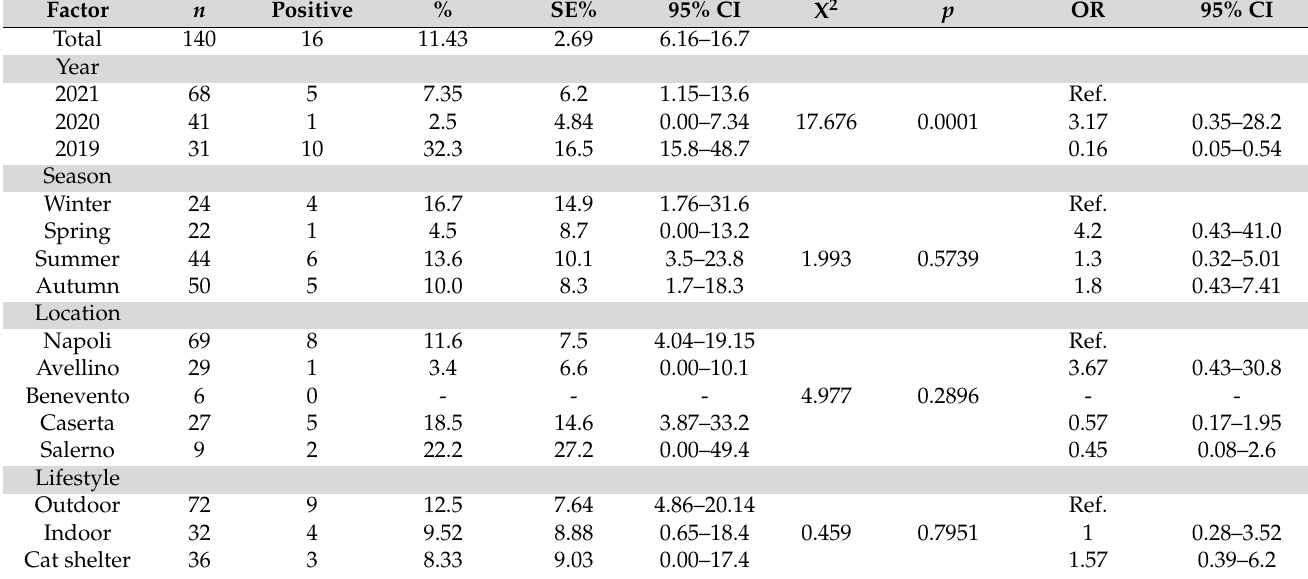
Table 6. RVA prevalence and risk factor analysis in cats from Campania Region